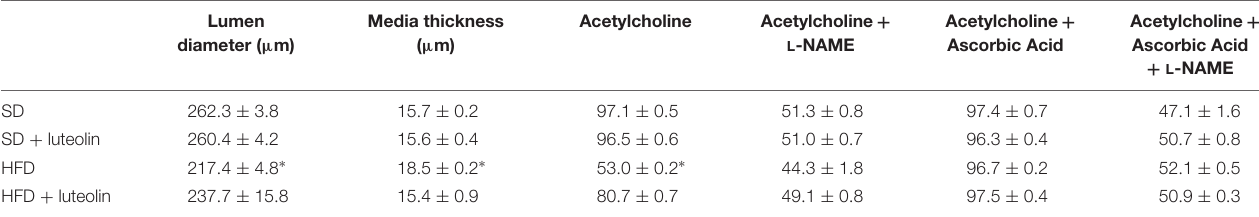
TABLE 1 | Morphological characteristics and maximal relaxation (%) to acetylcholine ± L -NAME, ascorbic acid or both of mesenteric vessels from the four